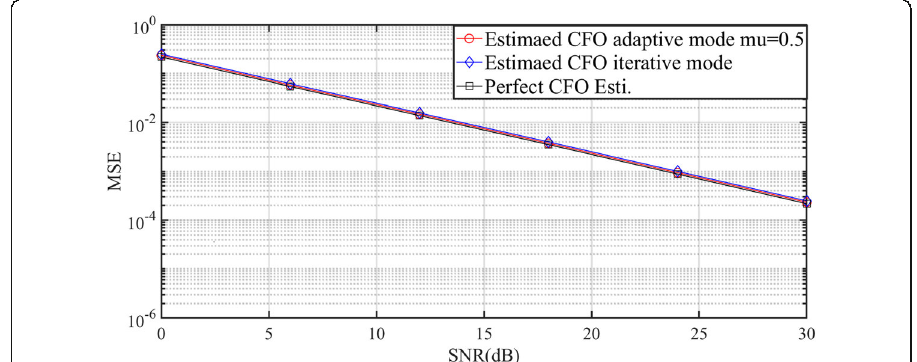
Fig. 12 The MSE performance for channel estimation in the adaptive mode at v = 0 km/h